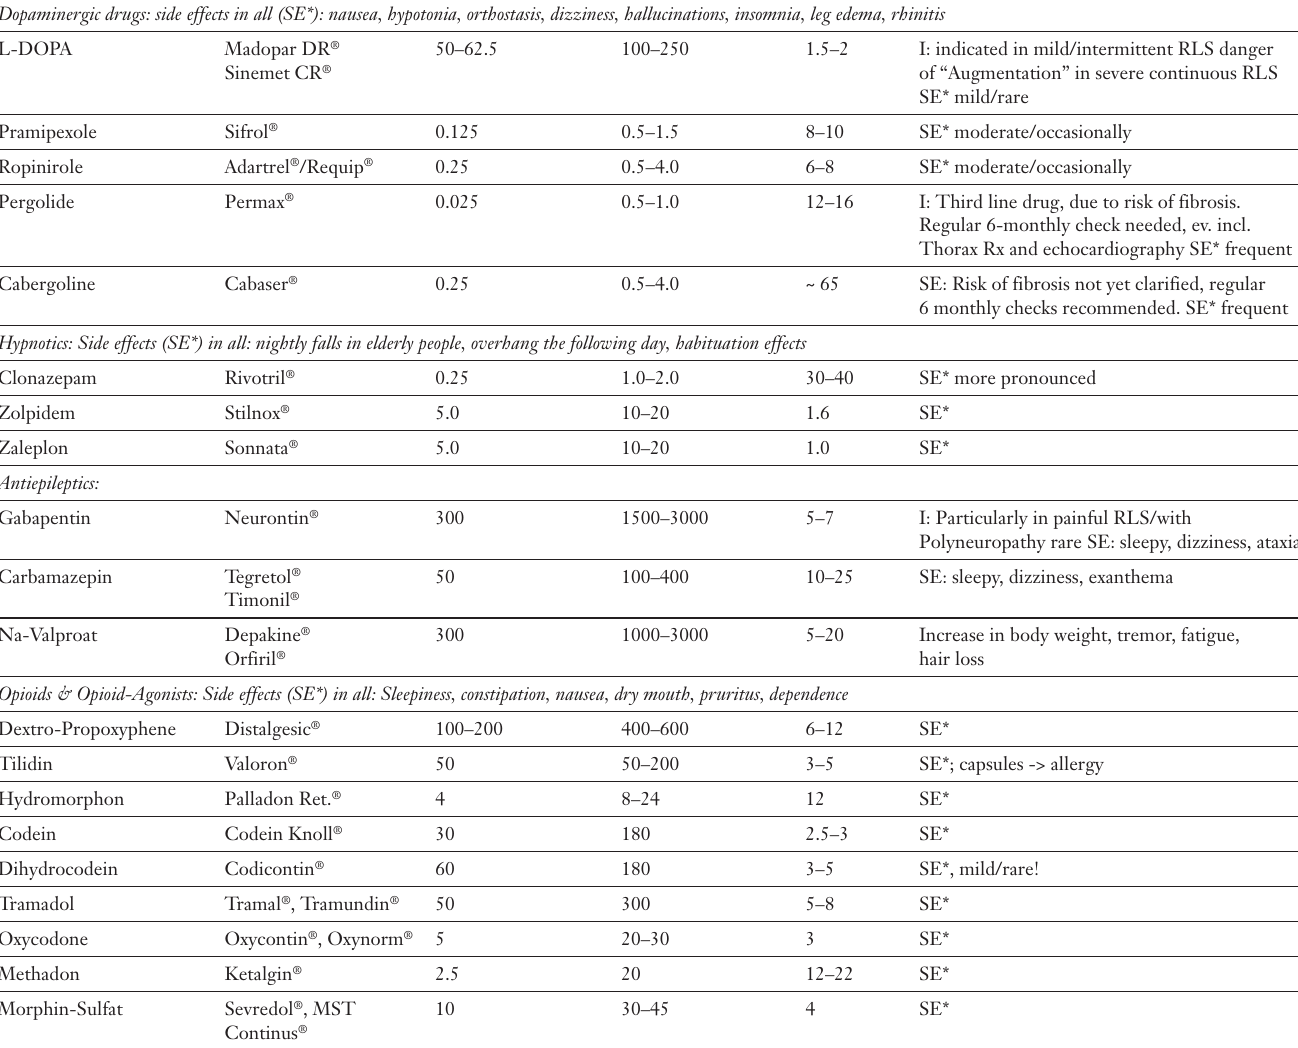
Table 5 Drug treatment in restless-legs